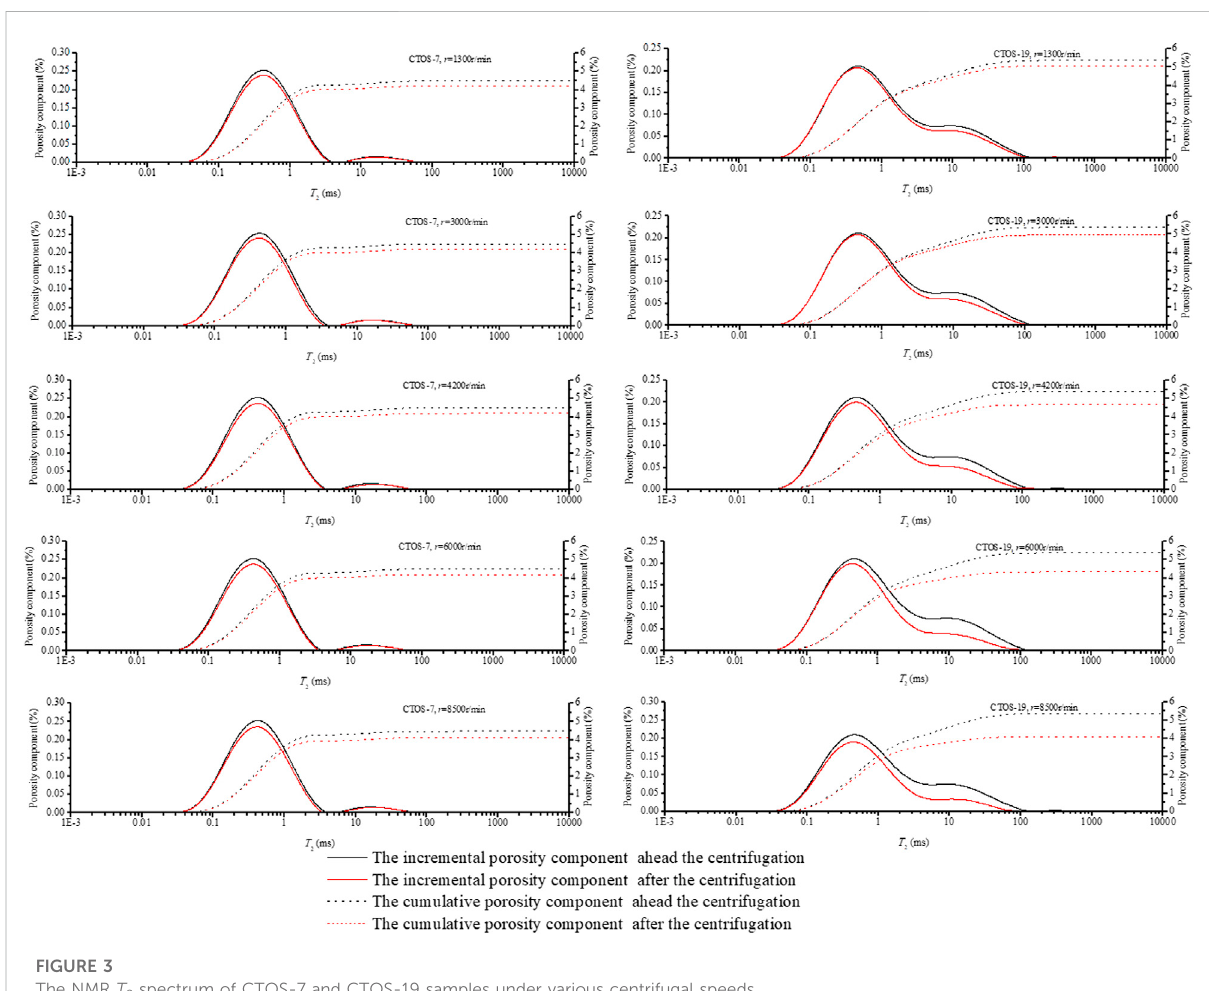
FIGURE 3 The NMR T 2 spectrum of CTOS-7 and CTOS-19 samples under various centrifugal speeds.